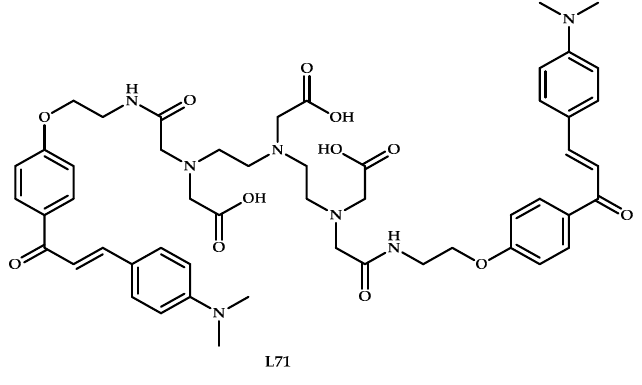
Figure 17. Chalchone-based ligand L71, designed for A β plaques binding.